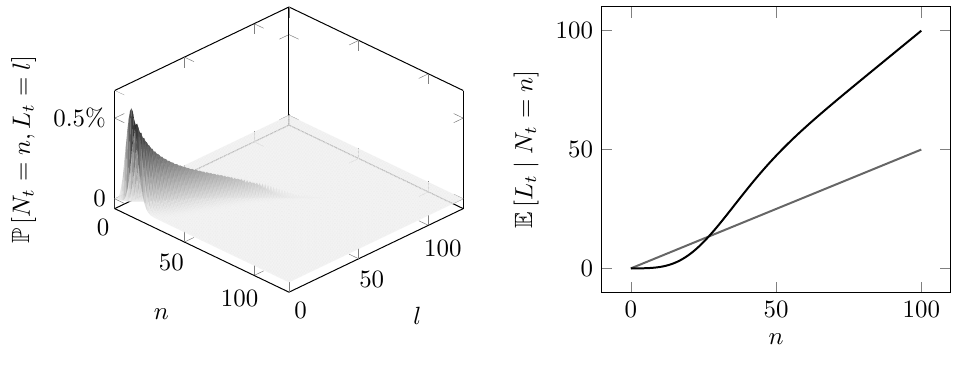
Figure 6: Number of defaults and loss dependence. The left panel displays the joint probability density of the number of default N on V . The right panel displays the expected loss given n defaults, when the loss amounts are respectively V -independent (grey line) and V -dependent (black line). The reference model is a one-factor homogeneous Gaussian copula with parameter equal to 0.25, default intensities λ = 0.05, a 5-year horizon, and contains N = 125 entities. The loss amount (cid:96) jt expected value of